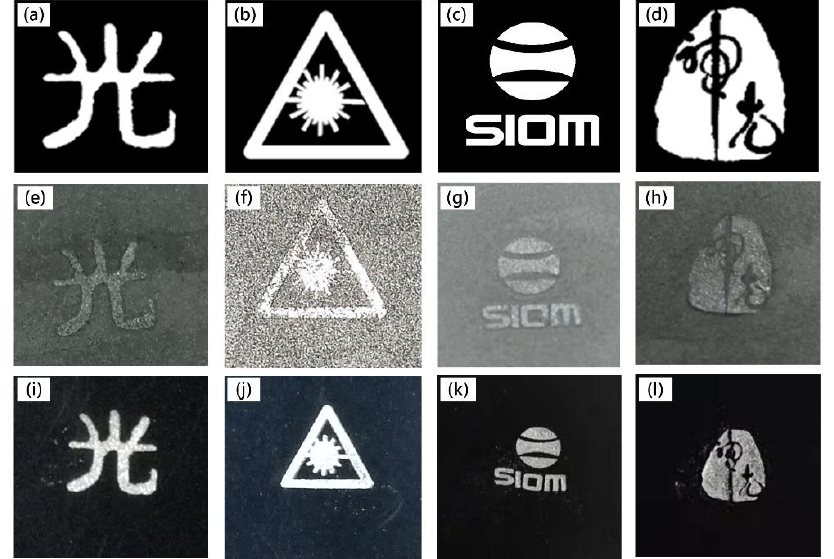
Figure 6. ( a – d ) Loading images on the OASLM. ( e – h ) Printing results. ( i – l ) Printing results separated from the construction platform.